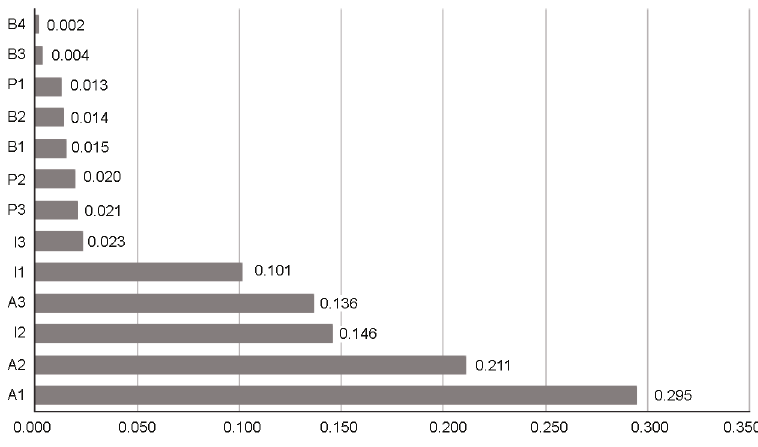
Figure 2. Priority of the factors influencing initial trust for